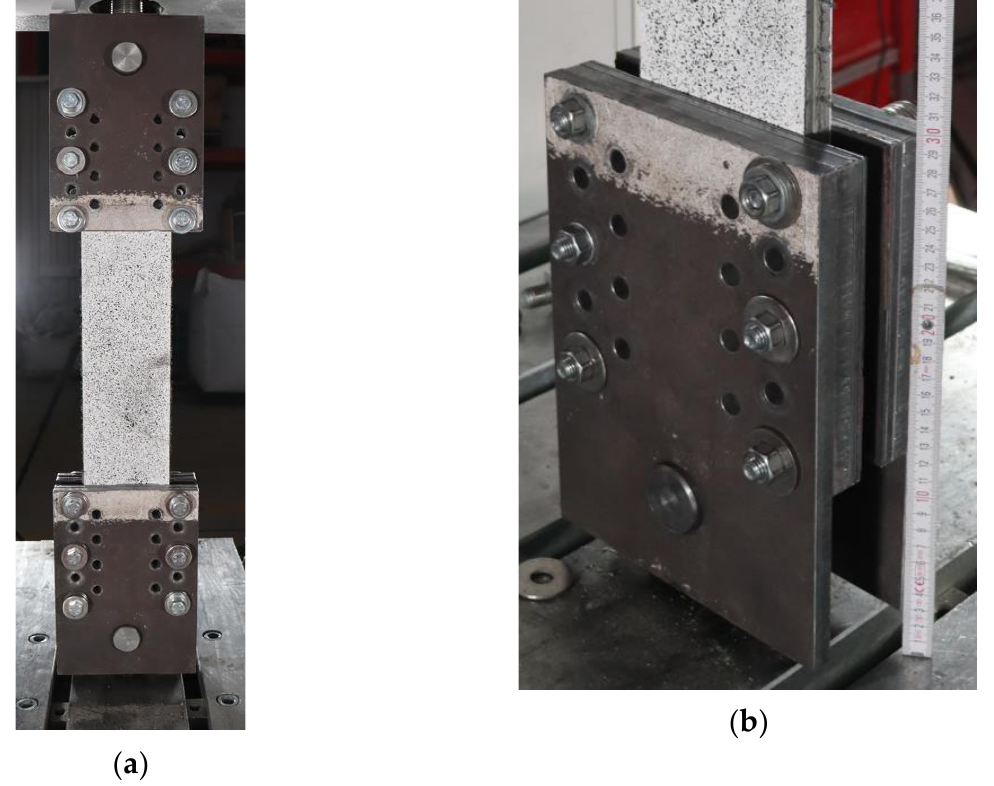
Figure 3. Specimen clamped in the testing machine ( a ), and a detail of the steel clamp ( b ).